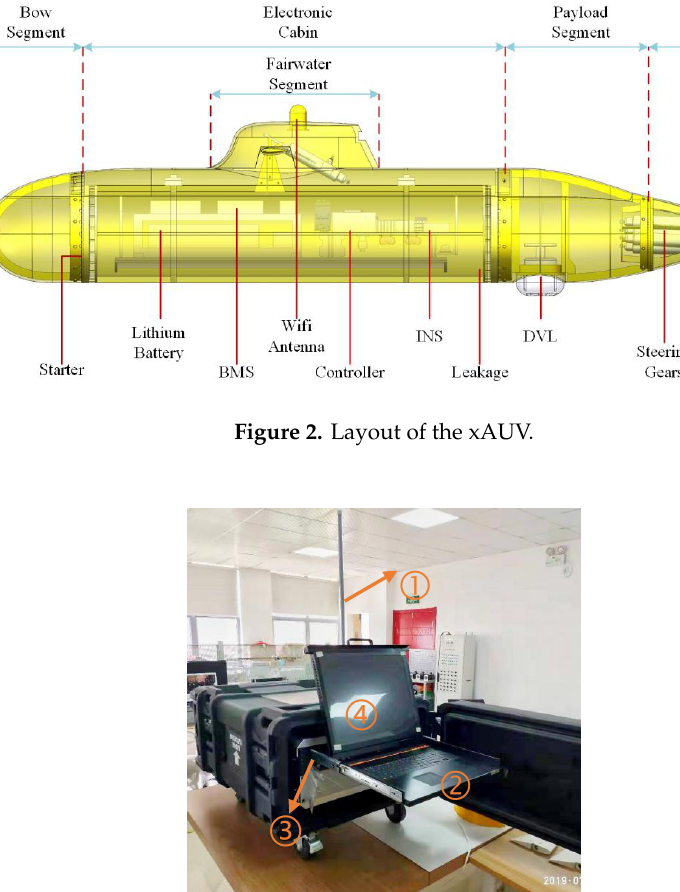
Figure 2. Layout of the xAUV.